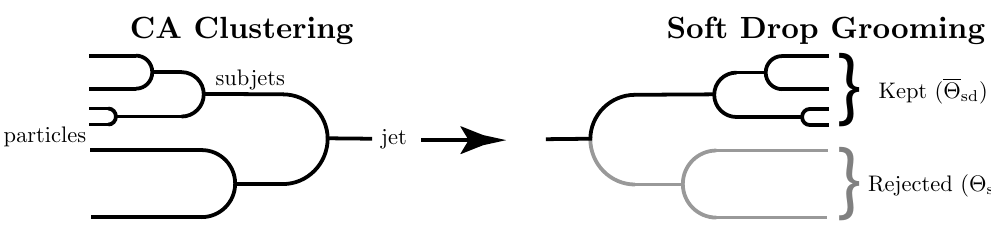
Figure 1 . Schematic of CA clustering and soft drop grooming algorithm. On the right the branches that fail to satisfy the soft drop criteria, shown in gray, are